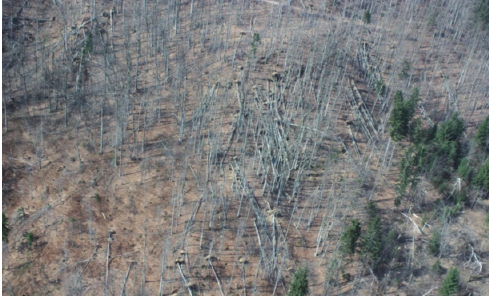
FIGURE 2. Uprooted and fallen